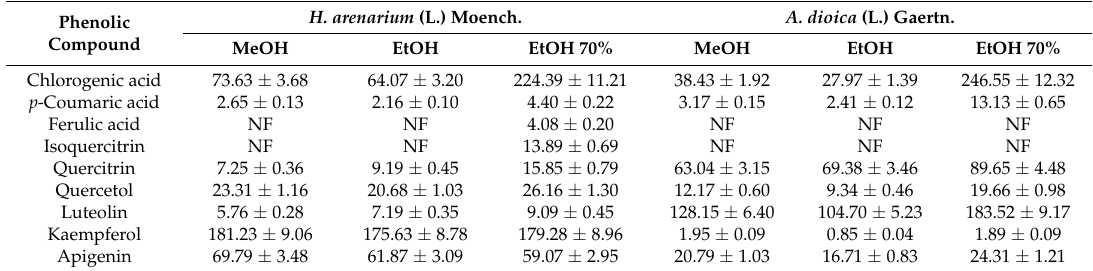
Table 2. The phenolic compounds identified in the flowers of H. arenarium and A. dioica extracts after acid hydrolysis (mg/100 g